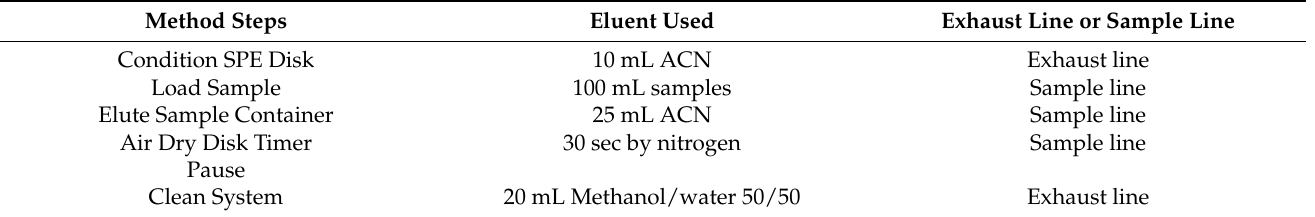
Table 8. Operating condition for SPE